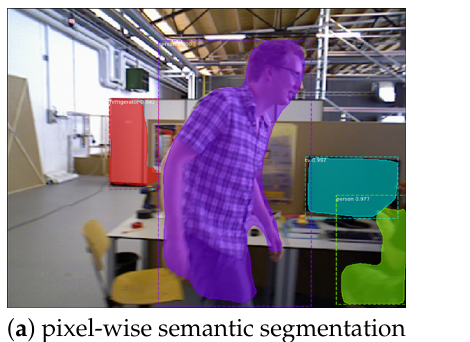
Figure 4. ( a ) The pixel-wise semantic segmentation of the RGB image. Different color areas represent different instances; ( b ) potentially dynamic objects areas. We extract the two instances named “person” in ( a ) as potentially dynamic